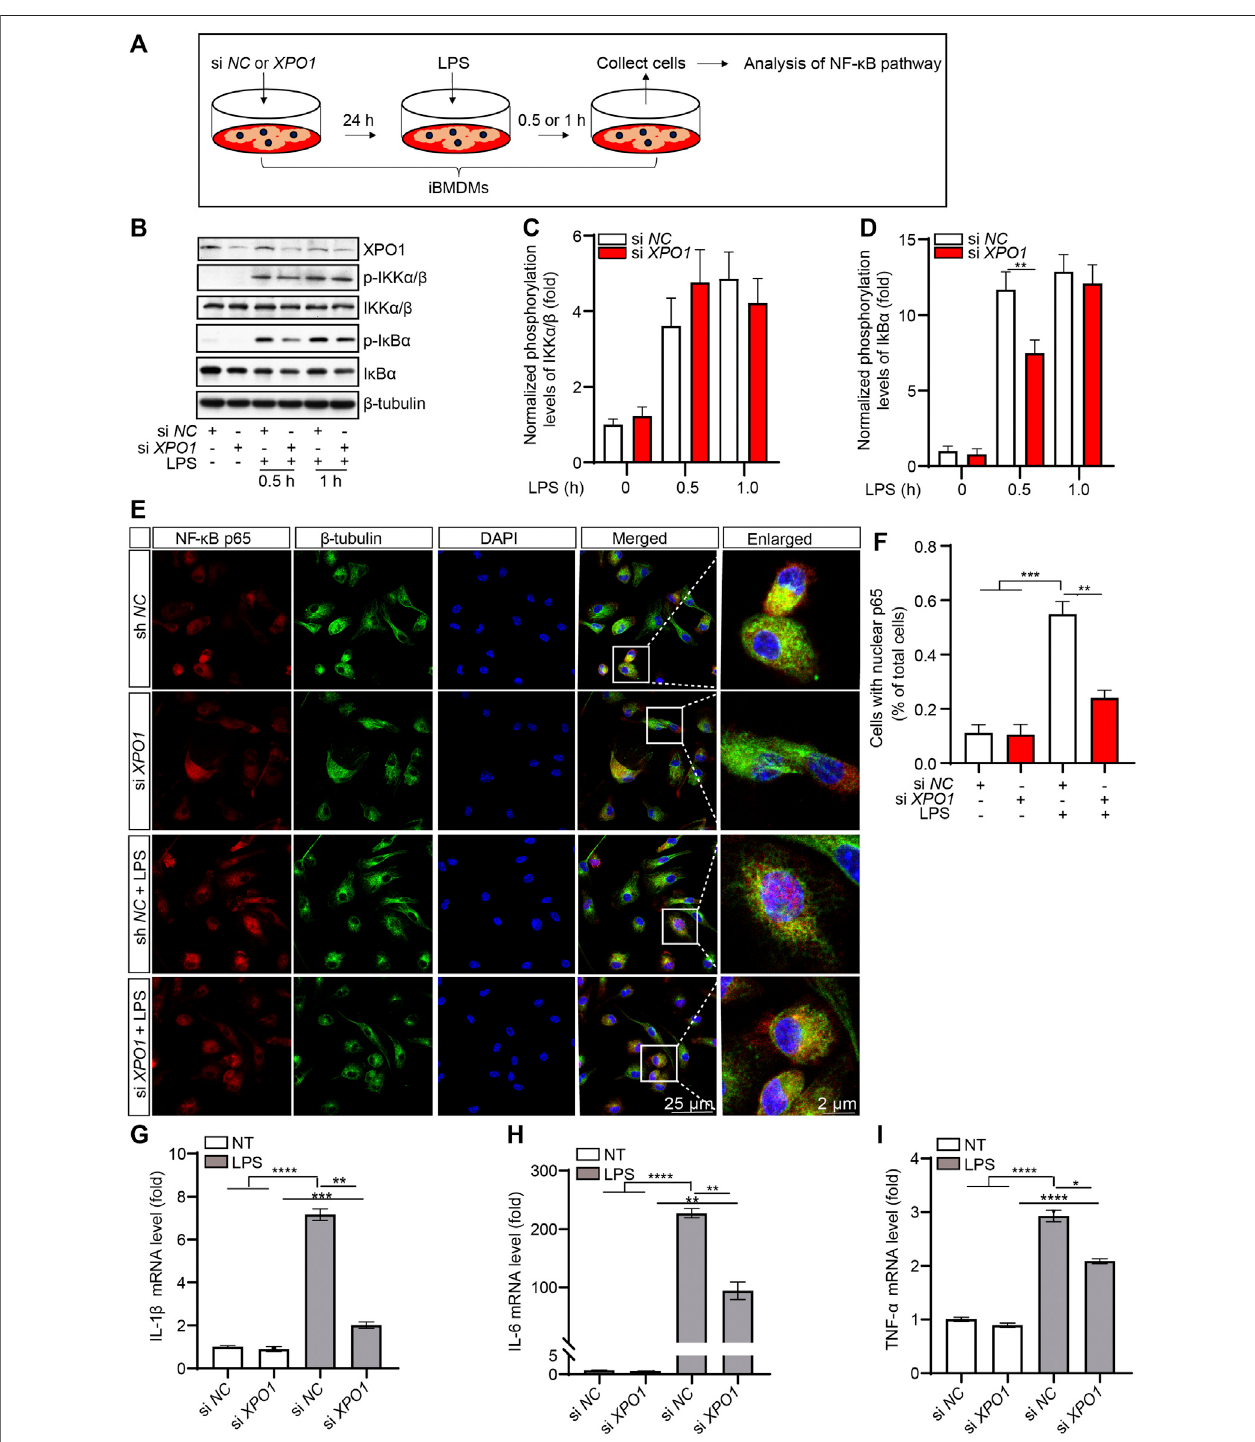
FIGURE4| SilencingXPO1inhibitsNF- κ Bsignalingpathwayandexertsanti-in fl ammatoryactivity. (A) iBMDMstransfectedwithsiRNAagainstXPO1orscrambled siRNA were treated with LPS for 0.5 and 1 h, respectively, and then the cell lysates were collected for analysis by Western blotting (B) . The gray values of the phosphorylated and total IKK α / β (C) and I κ B α (D) bands were analyzed with ImageJ. (E,F) PMs transfected with siRNA against XPO1 or scrambled siRNA were stimulatedwithLPSfor2 h,andthenthecellswere fi xedandstainedwitharabbitanti-NF- κ Bp65antibodyandmouseanti- β -tubulinantibody (E) ,andthenumber ofcells containingnuclear p65wasanalyzedbyImageJ (F) . Scalebars, 25 μ m forlow-magni fi cation images and 2 μ m forhigh-magni fi cation images, respectively. (G – I) iBMDMs transfected with siRNA against XPO1 or scrambled siRNA were treated with LPS for 6 h, and then the mRNA levels of IL-1 β (G) , IL-6 (H) , and TNF- α (I) were detected by real-time PCR. (* indicates p < 0.05, ** indicates p < 0.01, *** indicates p < 0.001, **** indicates p < 0.0001 by one-way ANOVA).